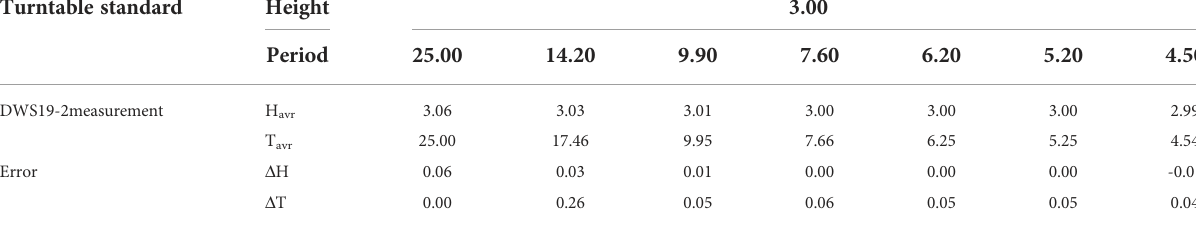
TABLE 3 Measurement at a height of 3 m (height unit: m; period unit: s).